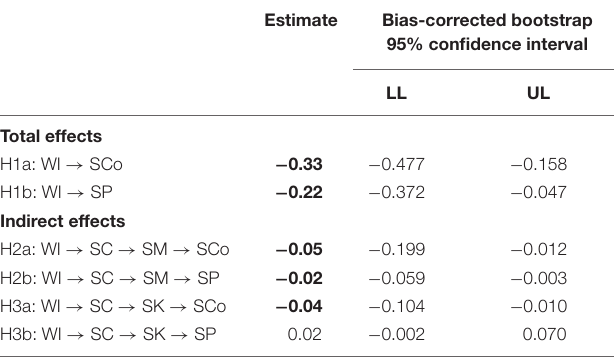
TABLE 4 | Standardized indirect and total effects of main effects and mediation